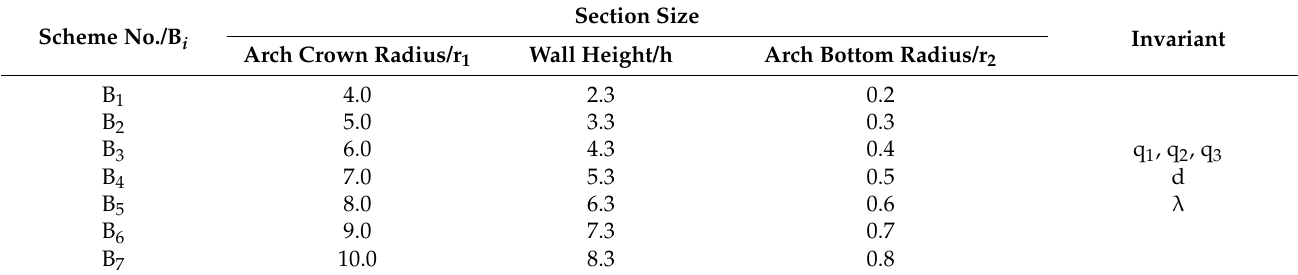
Table 2. Analysis scheme of different chamber section size.